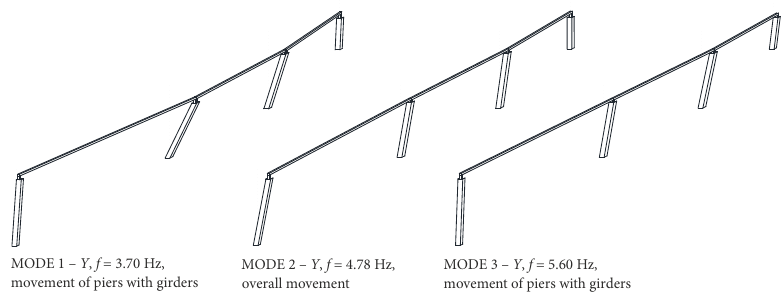
MODE 1 – Y , f = 3.70 Hz, MODE 2 – Y , f = 4.78 Hz, MODE 3 – Y , f = 5.60 Hz, movement of piers with girders overall movement movement of piers with girders Figure 16. Obtained mode shapes in Y direction in the second Ambient Vibration Survey